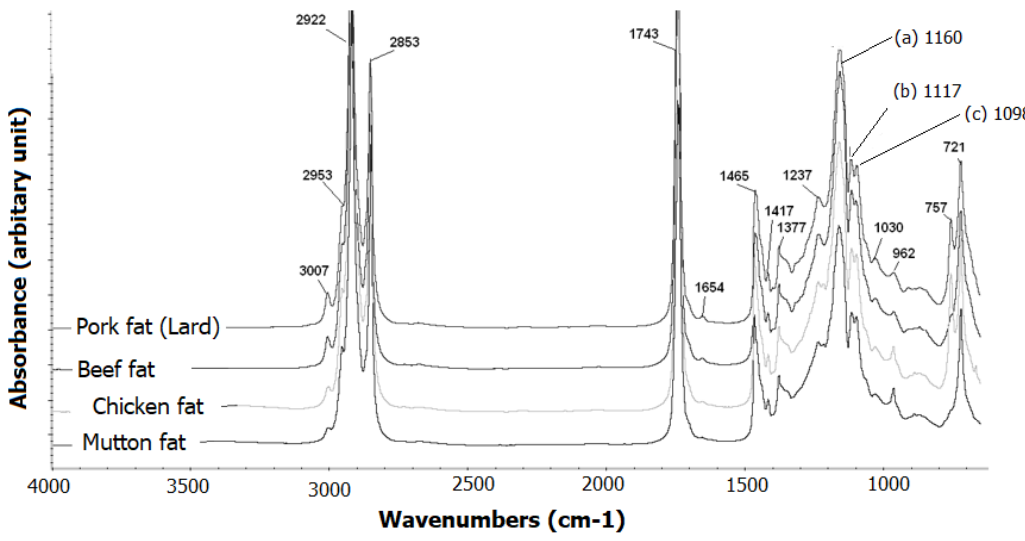
Figure 3. FTIR spectra of lard, beef fat, chicken fat, and mutton fat at wavenumbers of 4000–650 cm −1 . Taken with permission from the PhD thesis of Abdul Rohman [49].